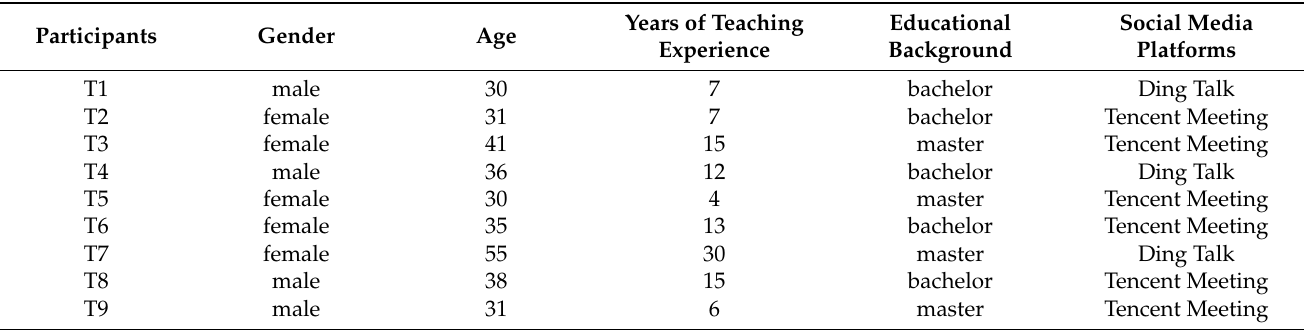
Table 1. Basic information of the nine